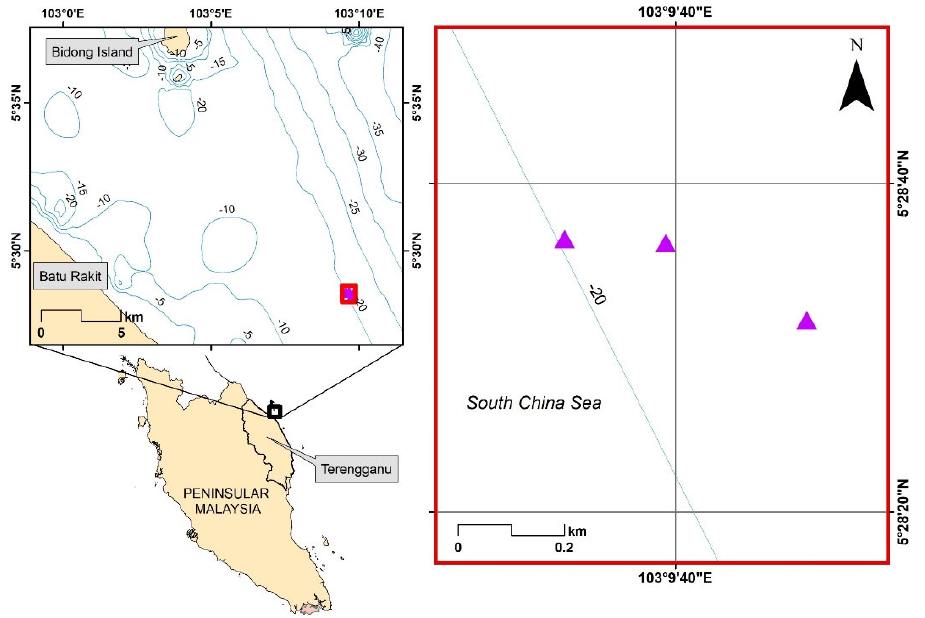
Figure 1. The three deployment locations of the BK AR across the Tukun Telaga Batin.